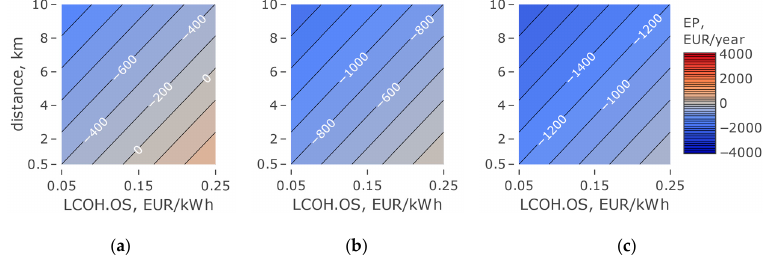
Figure 11. The Yearly Economical Profitable as a function of Levelized Cost of Heating from non- geothermal source (LCOH.OS) and distance between Geothermal Base Station and House, for Total Heat Demand (THD) = 5000 kWh/year and for: ( a ) M-TES price = 2000 EUR; ( b ) M-TES price = 6000 EUR; ( c ) M-TES price = 10,000 EUR.